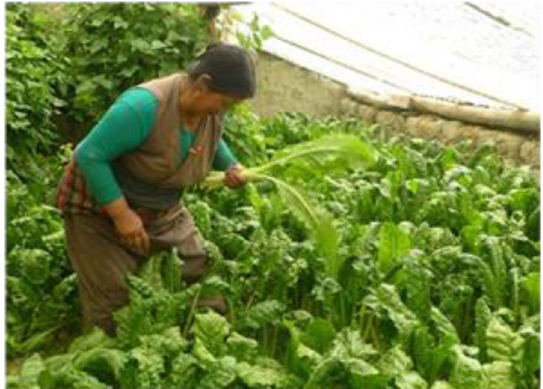
Fig. 12 Green vegetable farming becoming a new phenomenon for diet and source of cash